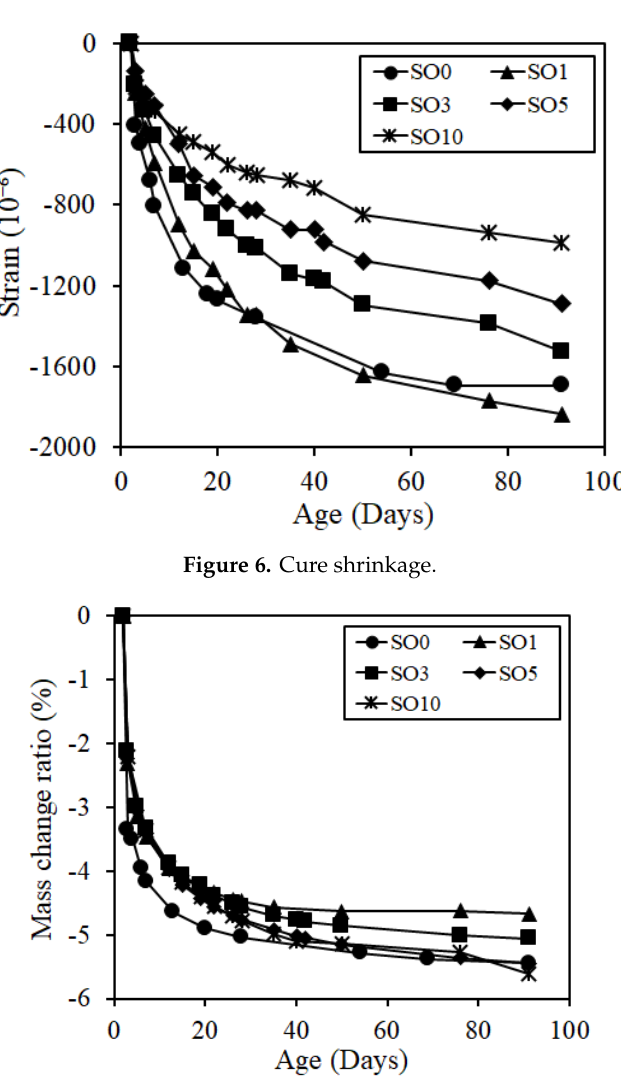
Figure 7. Mass change ratio.